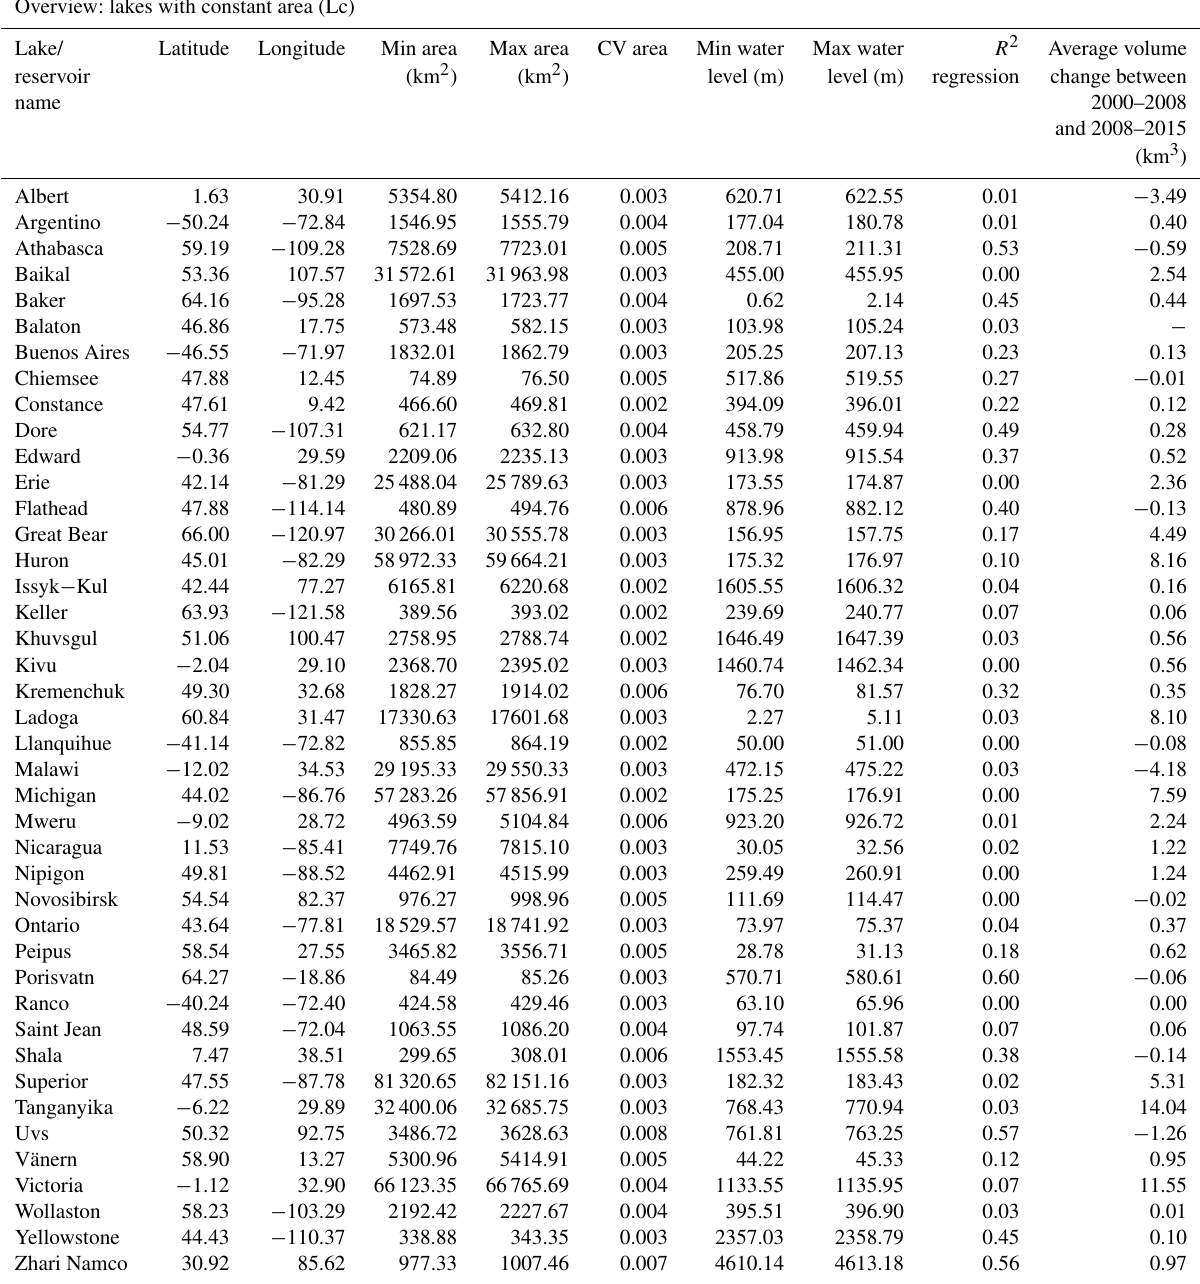
Table A1. Overview of lake properties for the three categories (Lc, LvP and LvG). Overview: lakes with constant area